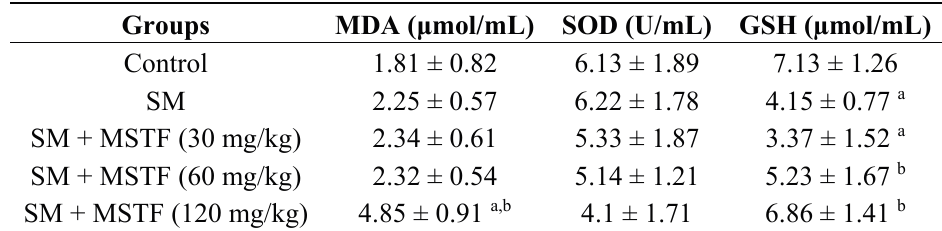
Table 1. Effect of MSTF on the antioxidant status in rat blood ( n = 10 rats/group). The measurement of MDA, SOD and GSH was carried out 7 days after the application of SM (mean ± SD).